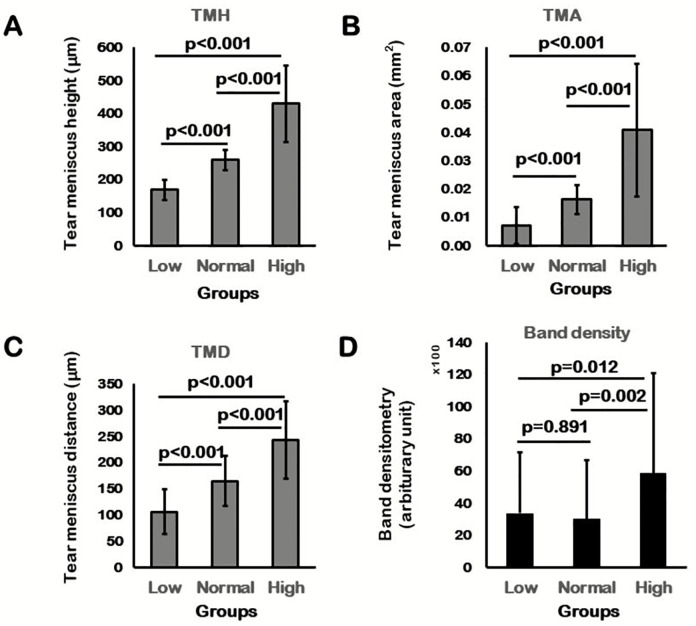
Post-hoc analysis of the three TMH groups.TMH (A), TMA (B), and TMD (C) showed statistically significant differences within the three TMH groups. D. Matrix metalloproteinase (MMP)-9 band density analysis of the three TMH groups showed significantly higher band density in the high TMH group than that in the low and normal TMH groups.